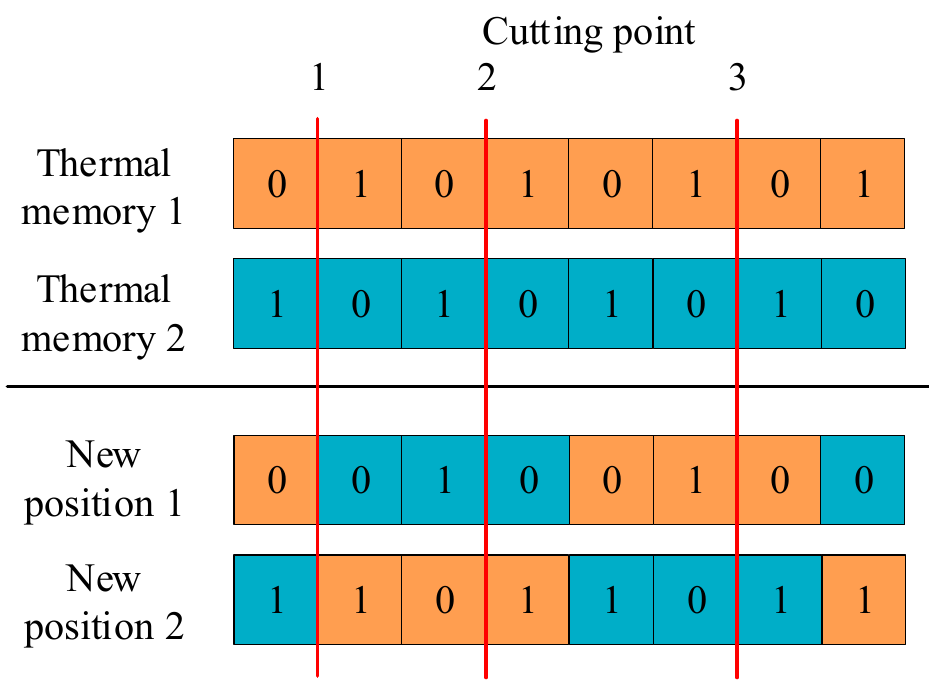
Figure 3. The crossover operator with three cutting